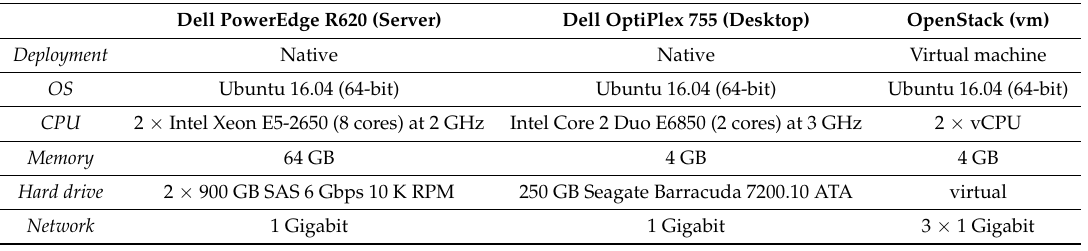
Table 2. Hardware configuration and specification of the 3 deployment environments.